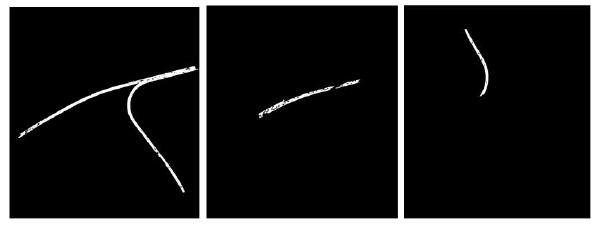
Figure 6. Viaducts in 2D Images